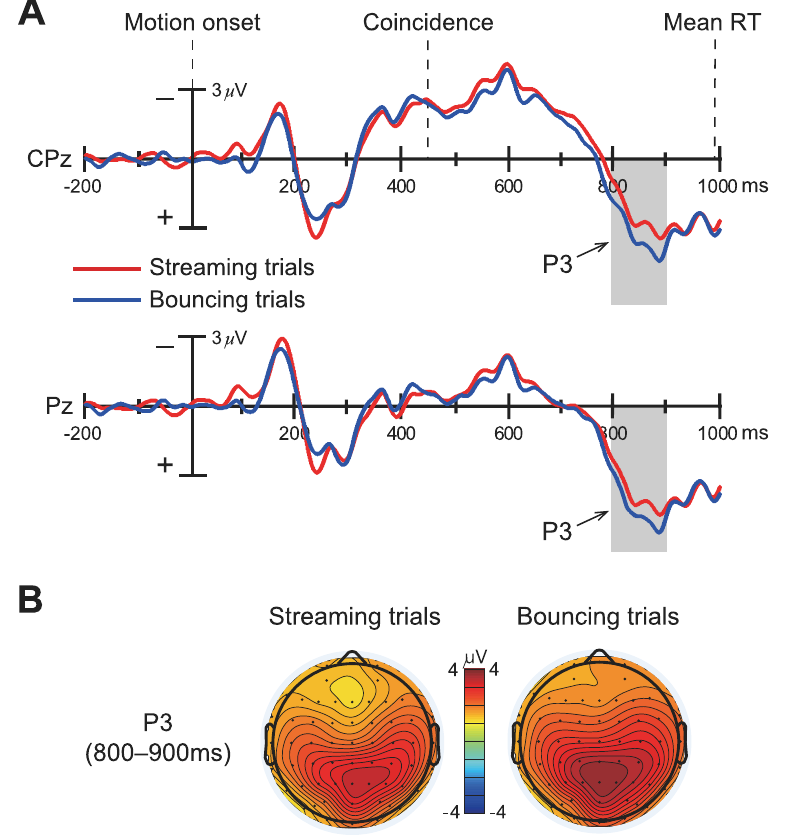
Figure 4. Grand-averaged ERP associated with the streaming and bouncing percepts over posterior electrodes. ( A ) P3 component (800–900 ms, shaded area) over parietal scalp elicited by the visual streaming/bouncing motion display. Shaded area shows the time window in which the P3 component was measured. Example waveforms shown here are from CPz and Pz electrodes. ( B ) Topographical distributions of P3 component for streaming trials and bouncing trials. Note that bouncing trials elicited larger P3 amplitude than streaming